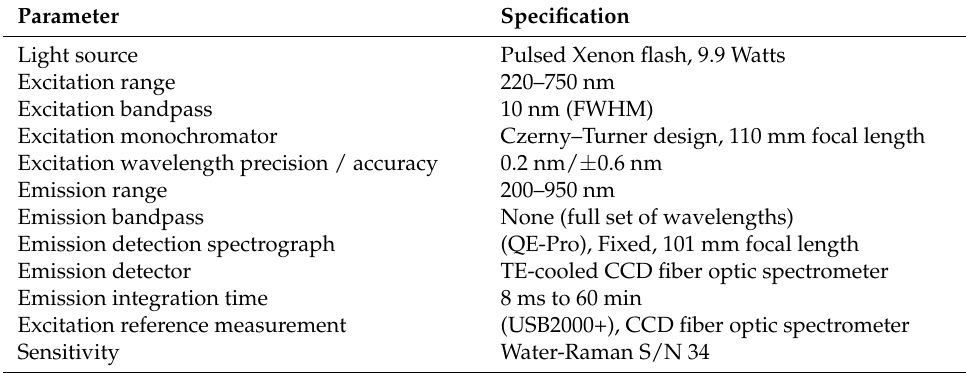
Table 1. Overview of the ‘Kallemeter’ EEMS sensor system, fluorescence hardware specifications.